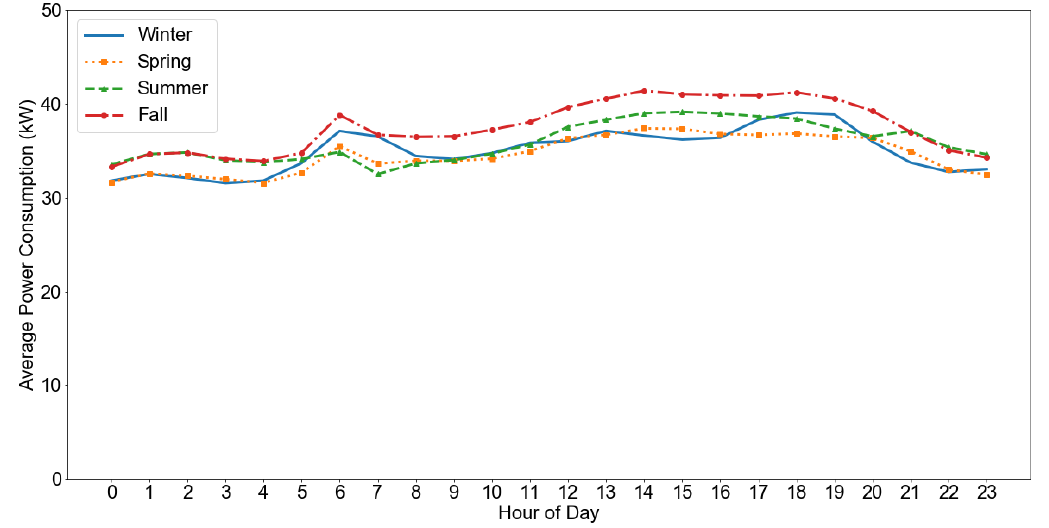
Figure 6. Daily load profile of the convenience store across different